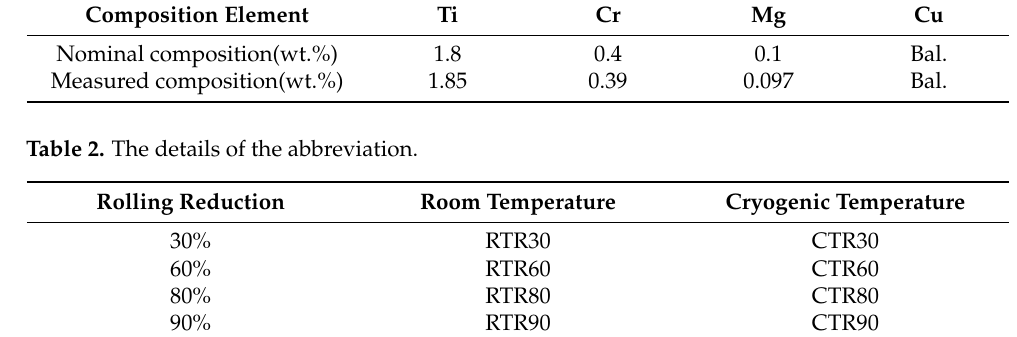
Table 1. The nominal and measured compositions of the alloy. Composition Element Ti Cr Mg Nominal composition(wt.%)